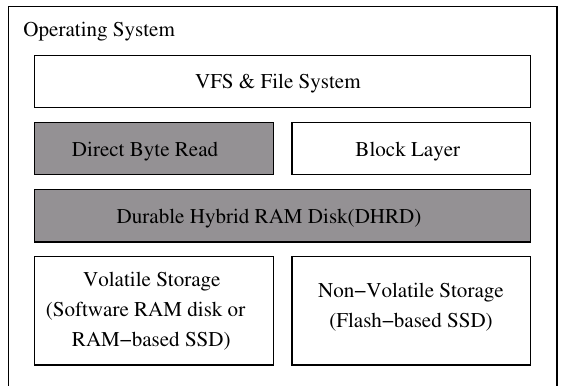
Figure 2. Software stack for the durable hybrid RAM disk (DHRD) with direct byte